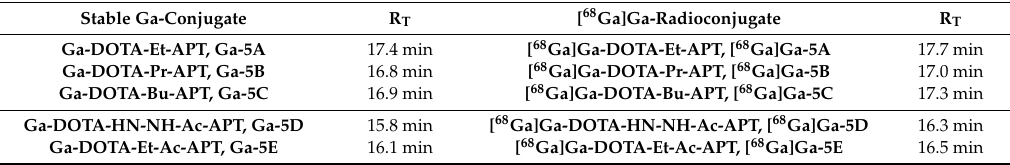
Table 2. R T of stable gallium conjugates and [ 68 Ga]Ga ‐ radioconjugates of all aprepitant derivatives. Stable Ga ‐ Conjugate